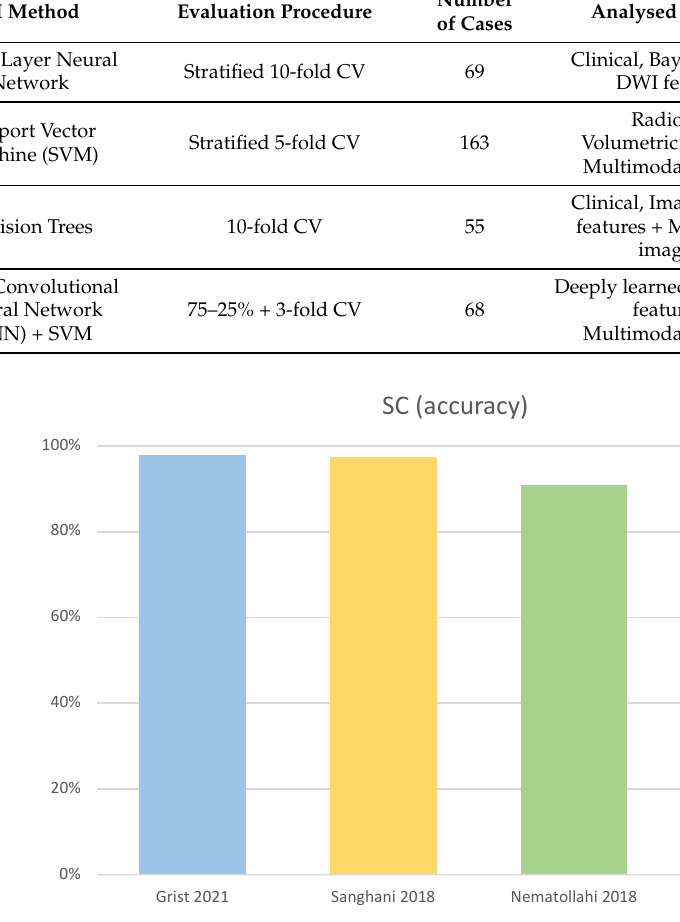
Figure 4. Performance of SC task: Graphical representation of the performance of the four best methods for the Survival Classification (SC) task, as evaluated by accuracy